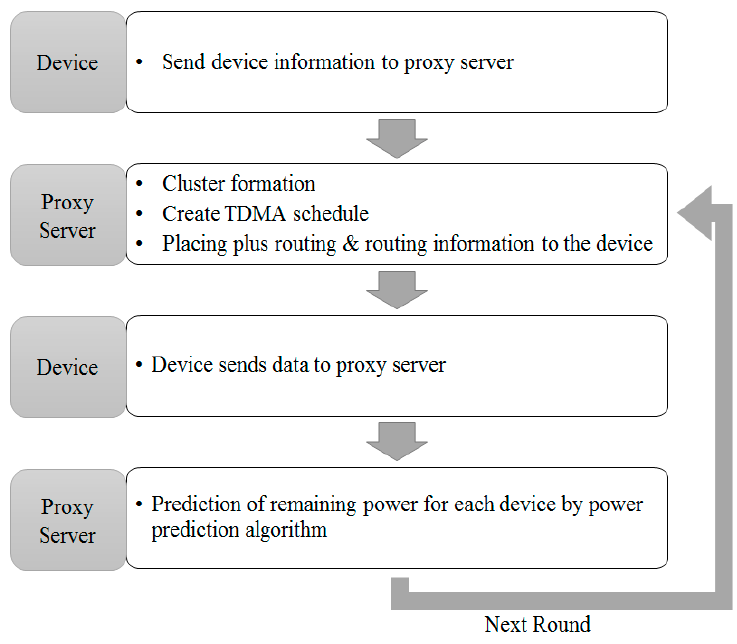
Figure 9. Model of Energy Level Estimation.